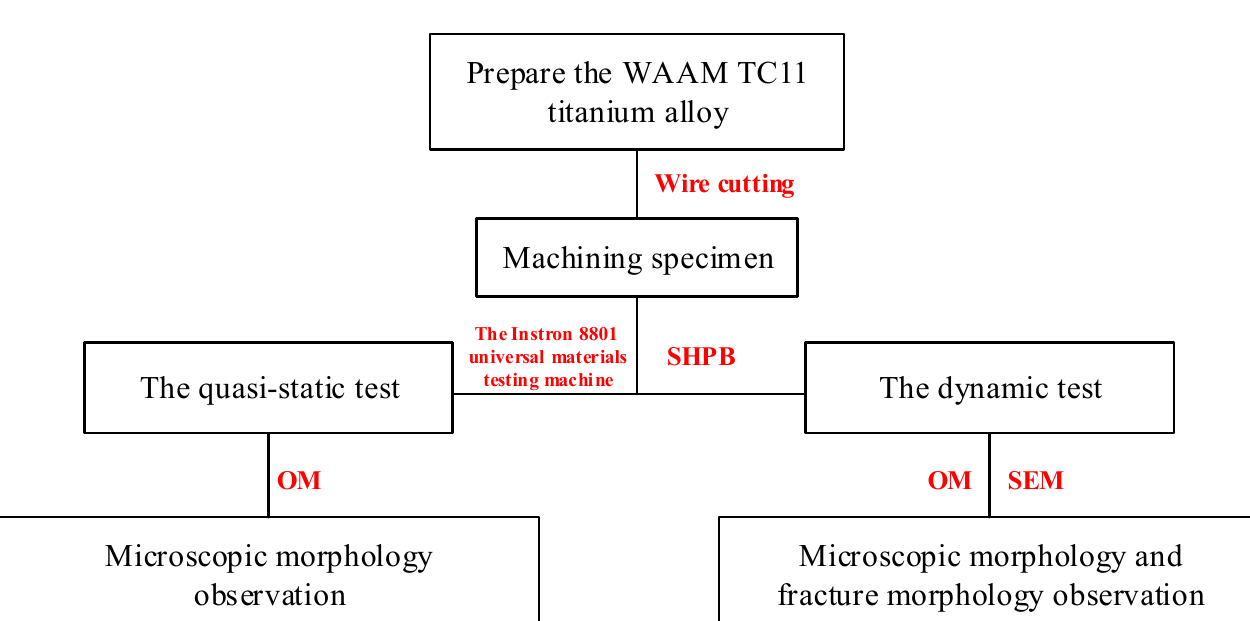
Figure 5. Schematic diagram of the workflow of experimental testing.